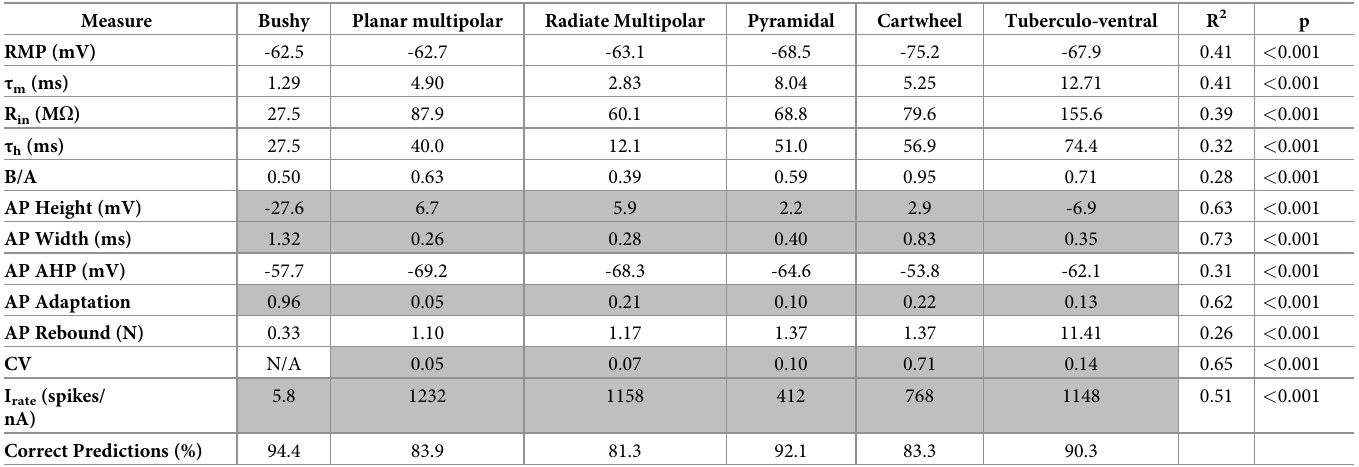
Table 1. Predictors and number of correct